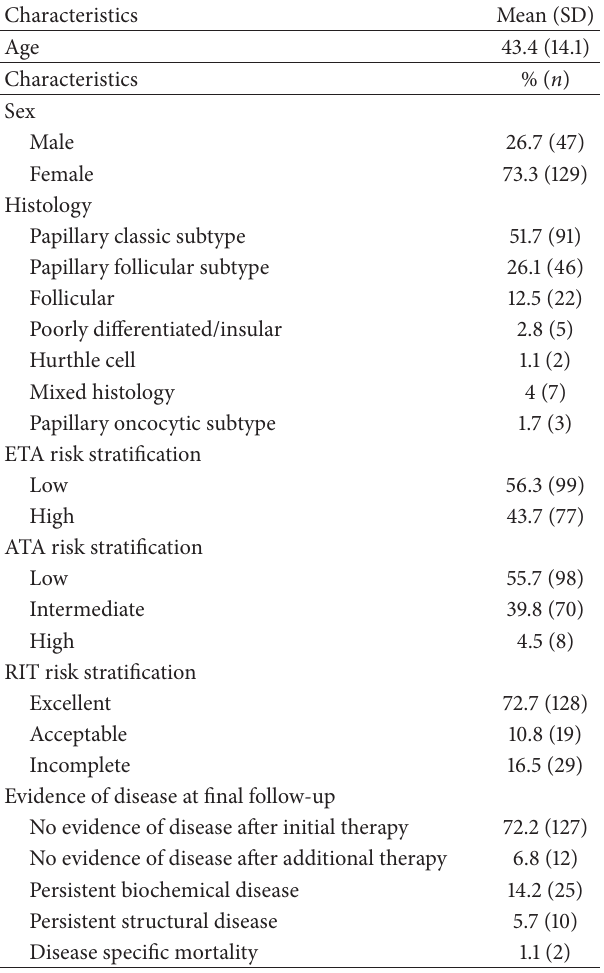
Table 2: Epidemiological characteristics of the